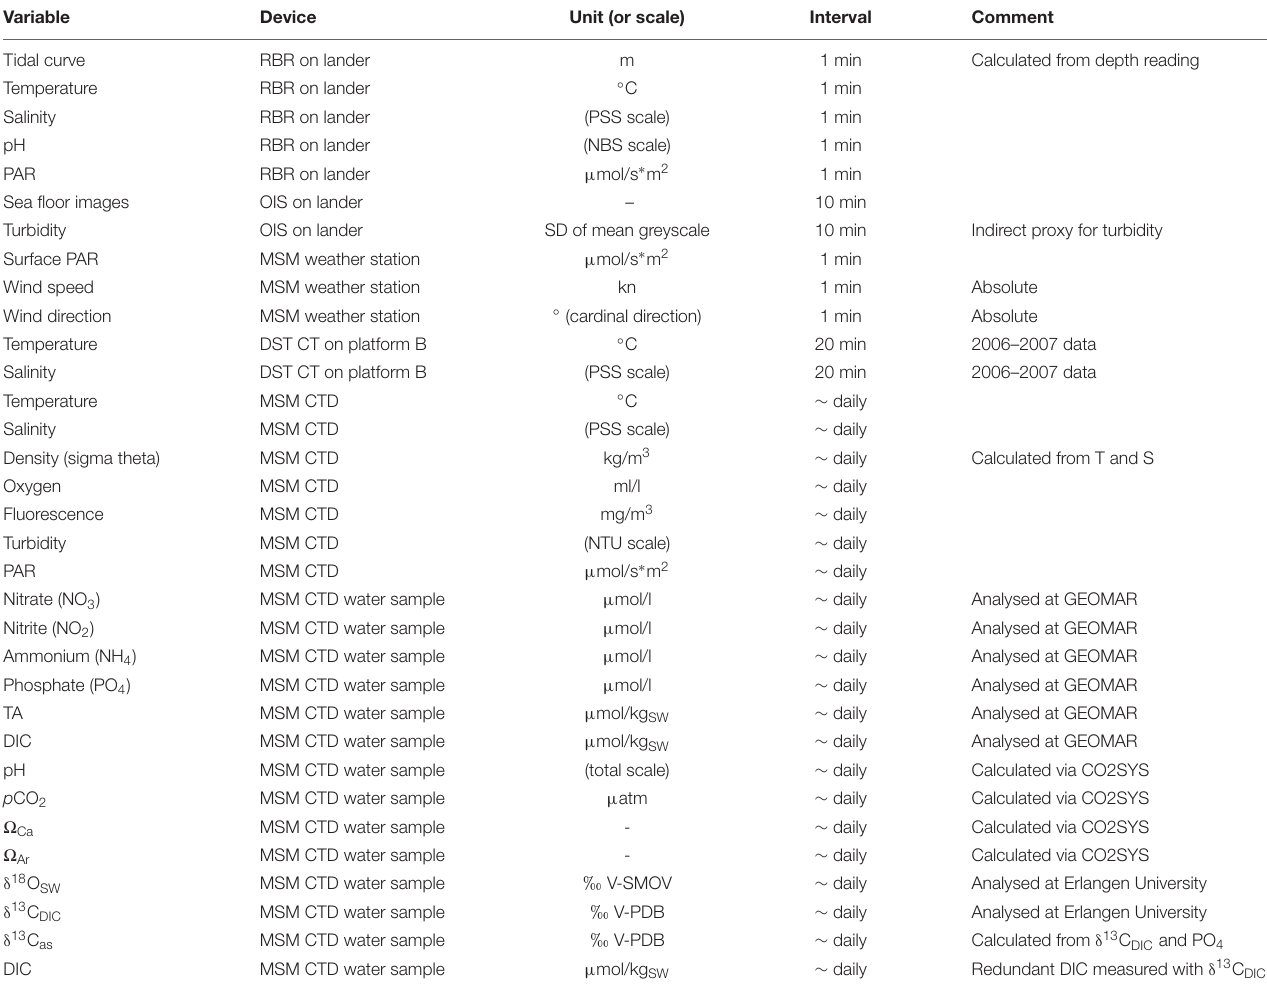
TABLE 1 | Overview of data and environmental variables reported in this study, with specifications of the applied instruments, the unit or scale the values are reported in, and the temporal resolution. Variable Device Unit (or scale)